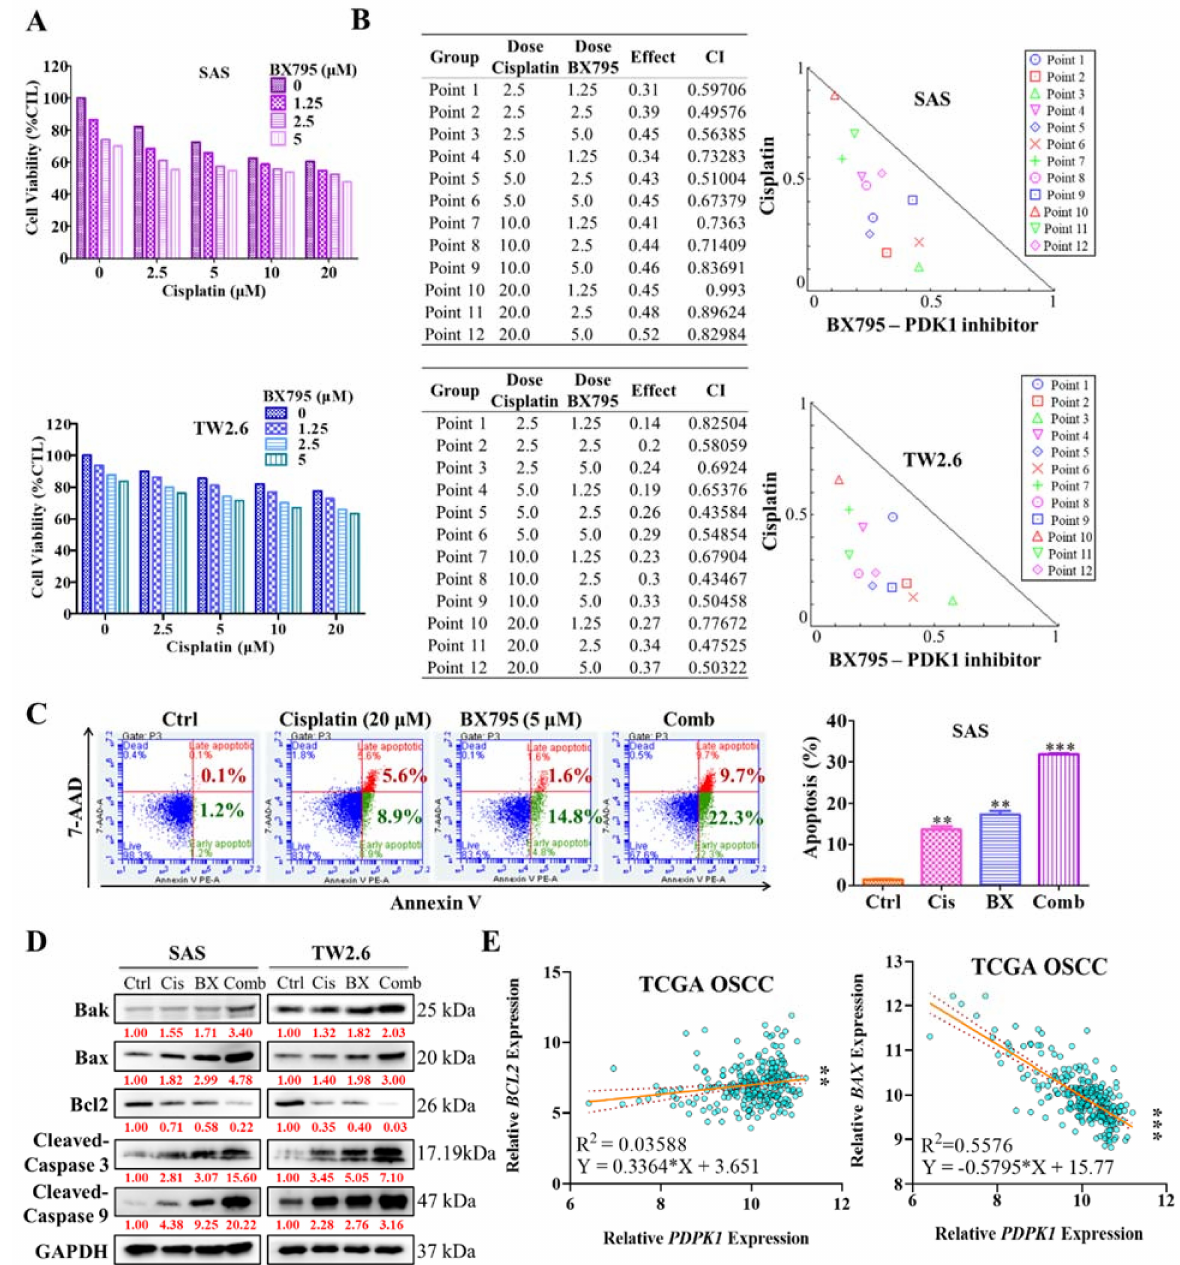
Figure 4. Synergistic anticancer effect of BX795 and cisplatin against OSCC cells. ( A ) Dose-response graphical charts of SAS and TW2.6 OSCC cells to BX795 and Cisplatin combination therapy show cell viability. ( B ) Combination effects were quantified using Compusyn software following the Chou–Talalay algorithm (Left). Representative isobologram figures of the combined potential of cisplatin and BX795 quantified through SRB assay (Right). Combinational effects are presented as the combination index (CI), where CI < 1 indicates synergism (inner triangle), CI = 1 (on the hypotenuse) indicates an additive effect, and CI > 1 (outer triangle) indicates antagonism. Data represent as mean ± SEM of three individual experiments, ** p < 0.01, *** p < 0.001. ( C ) SAS Cells were treated with cisplatin (20 µ M), BX795 (5 µ M), or their combination stained with annexin V/7-AAD before flow cytometry analysis. ( D ) The expression level of pro-apoptotic (Bak and Bax), antiapoptotic (Bcl2x) and apoptotic (cleaved caspase3/9) marker in OSCC cells as shown by Western blot analyses. ( E ) Correlation analysis of PDK1 ( PDPK1 ) with pro-apoptotic markers and anti-apoptotic markers, BCL2 and BAX ,